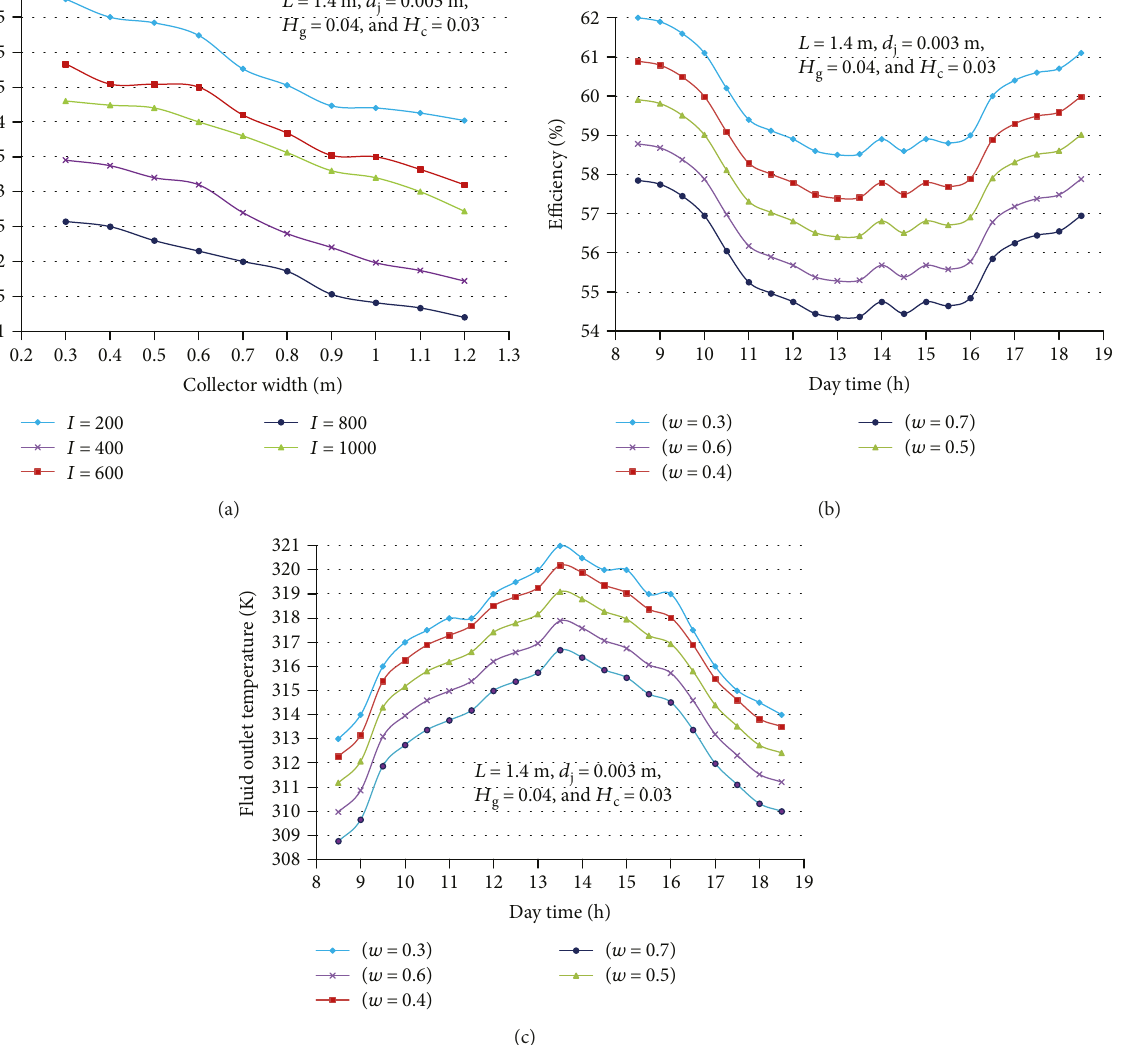
Figure 20: Prediction of the optimum width (W) of the proposed solar air heater. (a) SAH e ffi ciency versus collector width at di ff erent solar radiation levels. (b) Hourly SAH e ffi ciency over daytime at di ff erent collector widths. (c) Hourly air outlet temperature at di ff erent collector